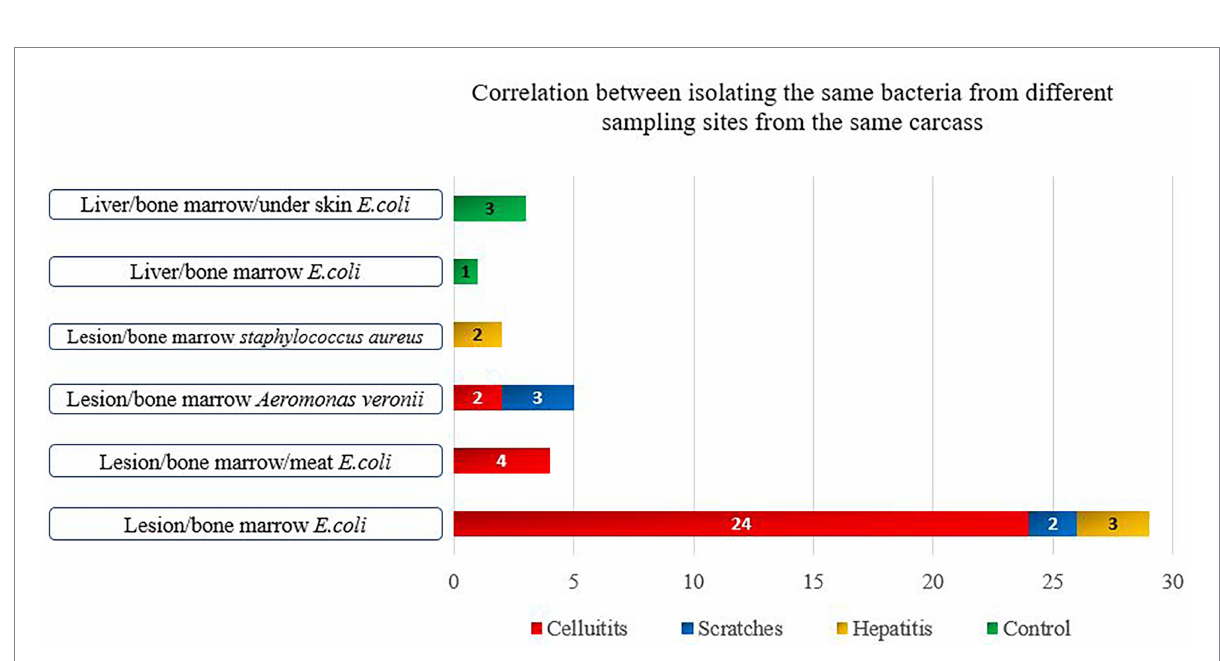
FIGURE 1 Bacterial species isolated from more than two samples’ types of the same condemned carcass.